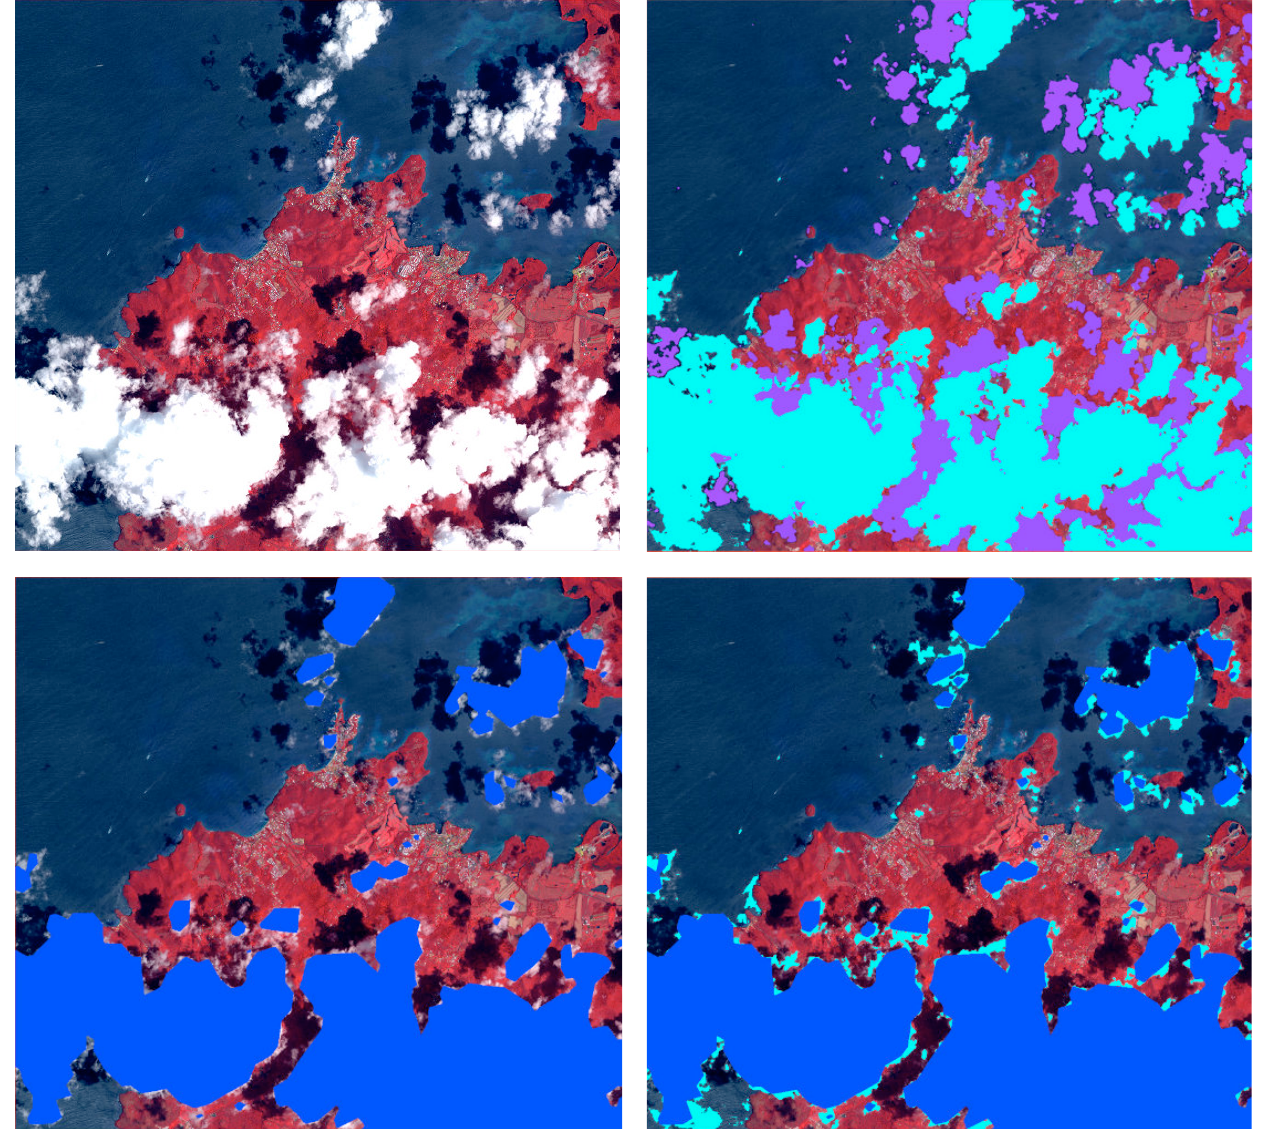
Figure 5. (top left) Initial Pléiades-HR image, depicted here in a CIR mode. (top right) the outcomes of our method; in cyan, the detection of clouds and in violet, the detection of shadows. (bottom left) The existing cloud mask, provided with input Pléiades-HR images. (bottom right) The existing cloud mask (in blue), superimposed on our cloud mask (in